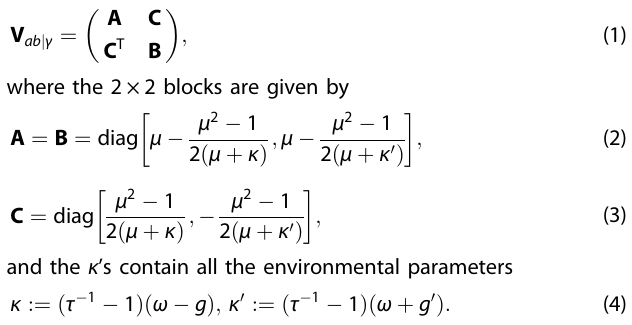
ffiffiffiffiffiffiffiffiffiffiffiffiffi